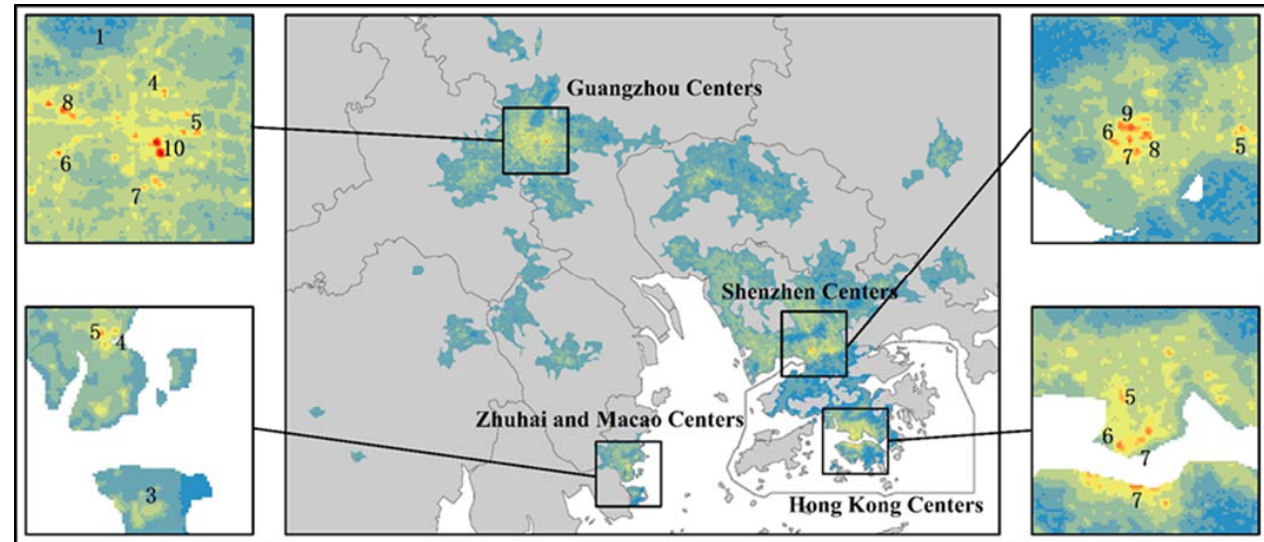
Figure 10. Evaluation results of urban poly-center hierarchical level (the numbers in the figure indicate the hierarchy of urban centers). Table 4. The hierarchical level evaluation of the urban